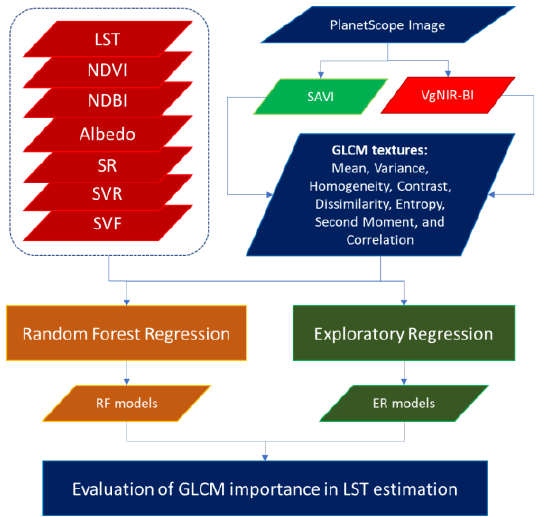
Figure 3. General workflow of the study.